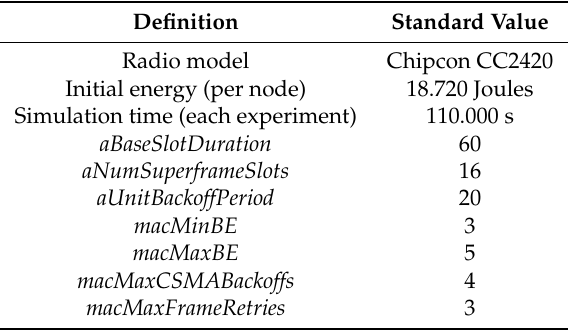
Table 4. Simulation